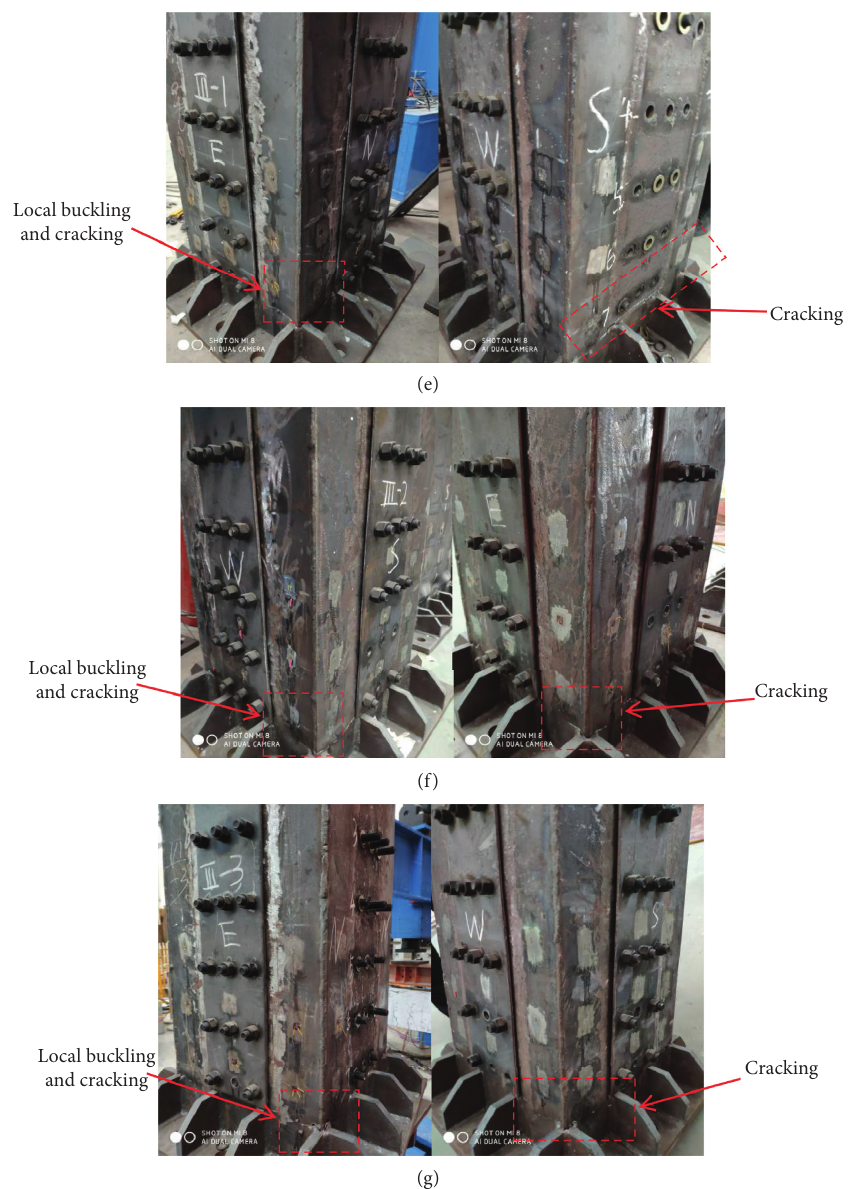
Figure 7: Failure modes of pseudostatic specimens. (a) Specimen I-1. (b) Specimen II-1. (c) Specimen II-2. (d) Specimen II-3. (e) Specimen III-1. (f) Specimen III-2. (g) Specimen